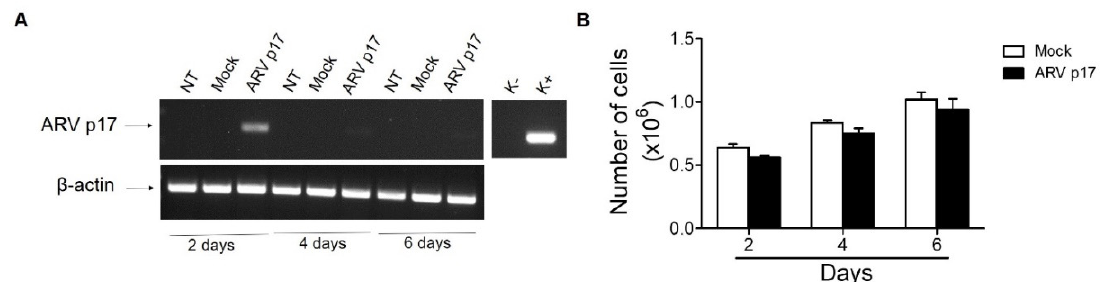
Figure 1. Avian Reovirus p17 (ARV p17) expression in HUVECs. HUVEC cells were mock-nucleofected (Mock) or nucleofected with ARV p17-expressing plasmid (ARV p17). ( A ) The presence of ARV p17 mRNA was analyzed by RT-PCR at different days post-nucleofection. K - , negative control, water; K + , positive control, ARV p17-expressing plasmid. As a control, amplification of β -actin mRNA is also shown. ( B ) At each time point, cells were counted using the trypan blue exclusion method. Values represent the mean ± standard deviation (SD) of one representative experiment out of three with similar results, performed in triplicates.